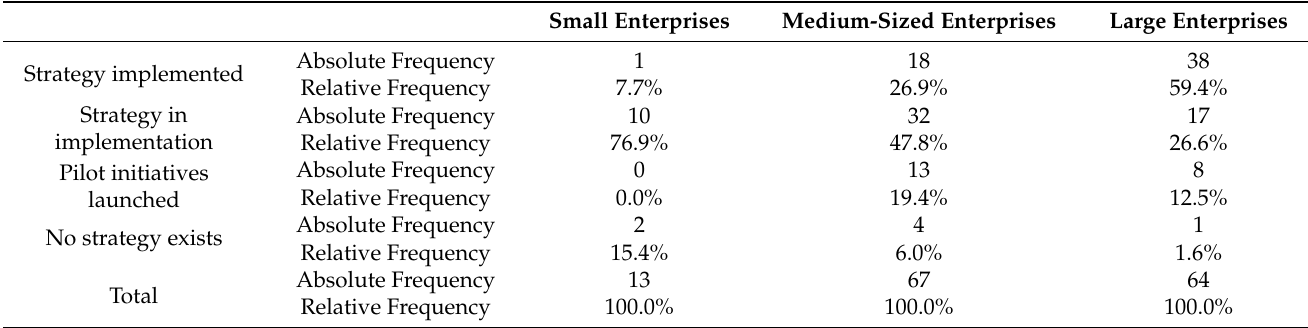
Table 4. Data file structure by implementing Industry 4.0 in logistics.